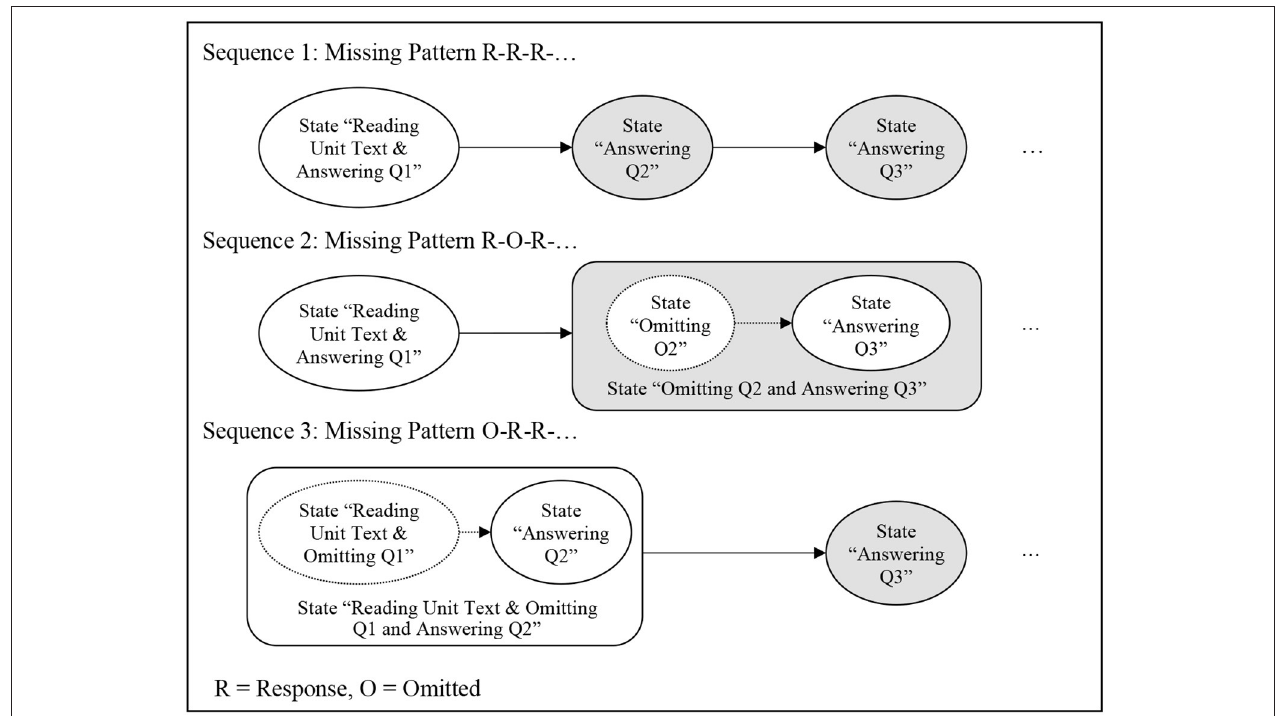
FIGURE 2 | State sequences for the responses to the first 3 questions for 3 different missing response